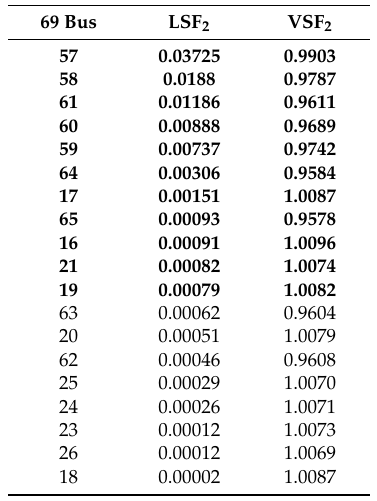
Table 5. The results of LSF and VSF of 69-bus IEEE distribution network.